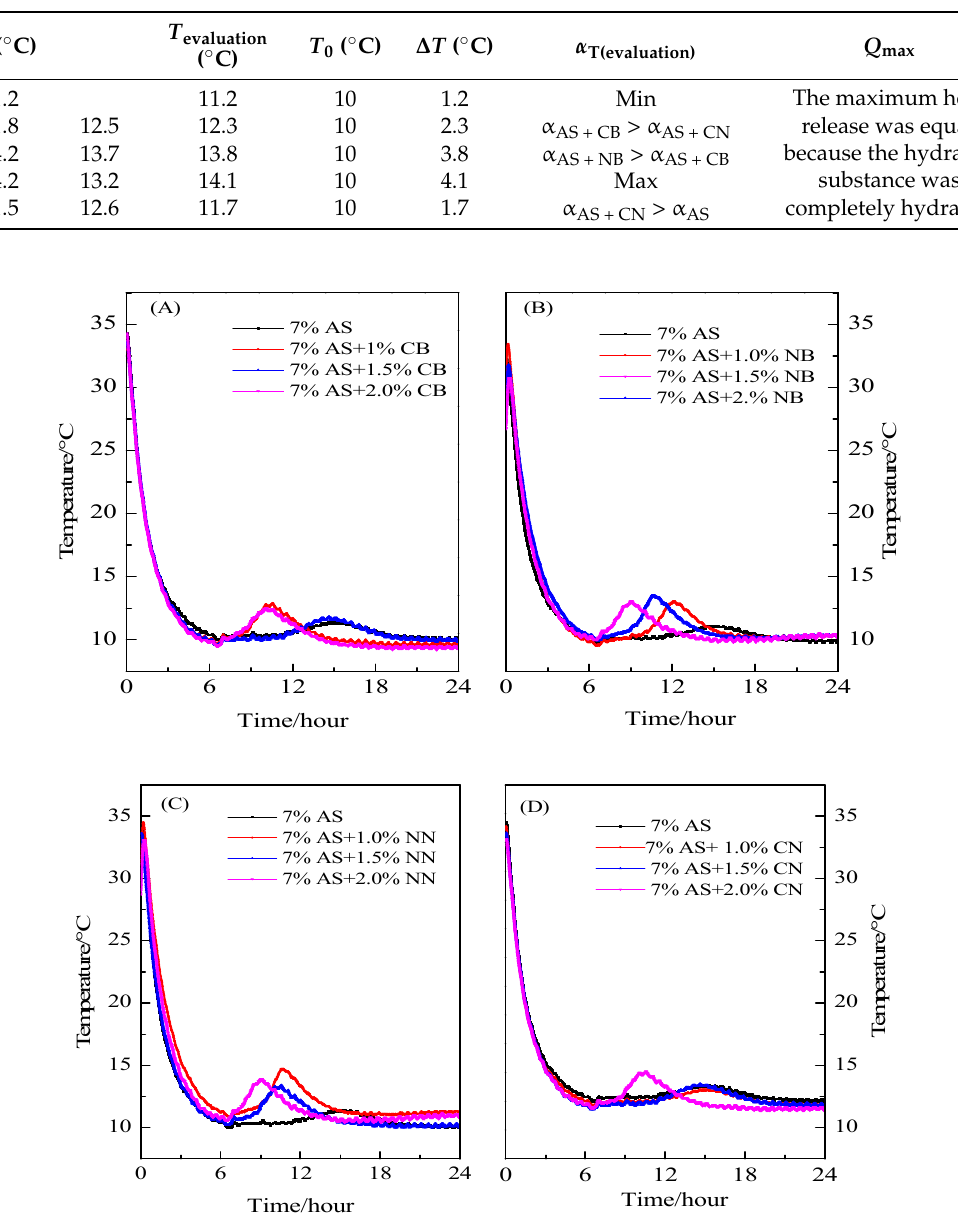
Table 6. Hydration-related parameters.